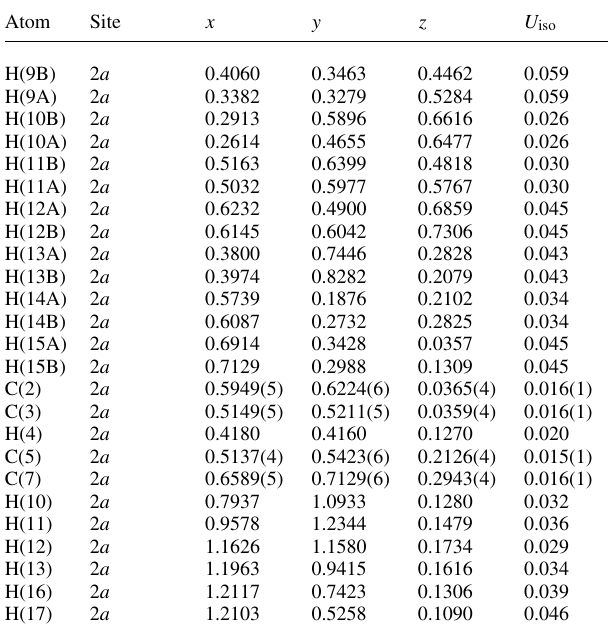
Table 2. Atomic coordinates and displacement parameters (in Å 2 )